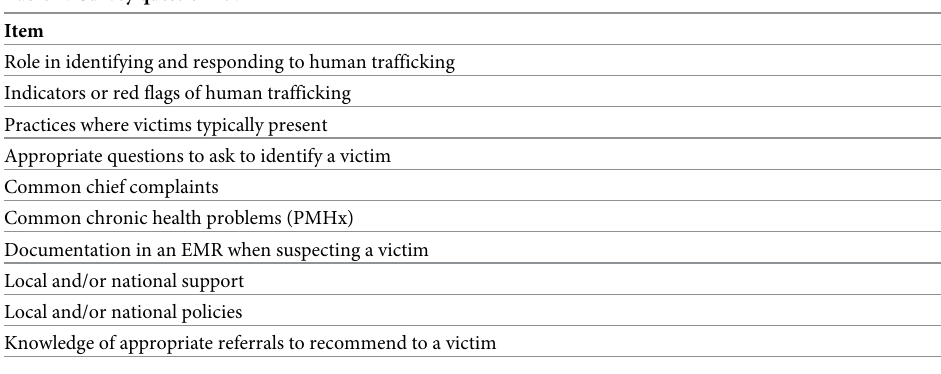
Table 1. Survey question